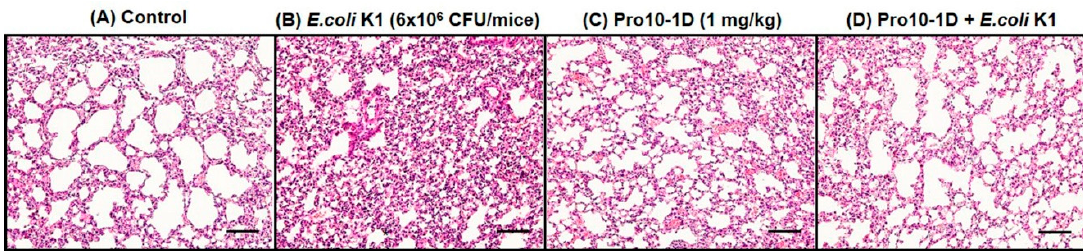
Figure 13. Pro10-1D treatment ameliorates lung microanatomical changes in E. coli K1-infected mice. Representative hematoxylin and eosin staining of lung tissue of ( A ) the control shows normal lung anatomy, while that of ( B ) E. coli K1-infected mice (6 × 10 6 CFU/mice, Intra-peritoneal injection (I.P.)) displays severe lung damage associated with neutrophil infiltration. ( C ) No sign of lung damage can be observed in the Pro10-1D-treated control mice (1 mg/Kg, I.P.), while ( D ) Pro10-1D pretreatment distinctly ameliorated the aberrant changes induced by E. coli K1 infection ( × 20 magnification, scale bar, 100 µ